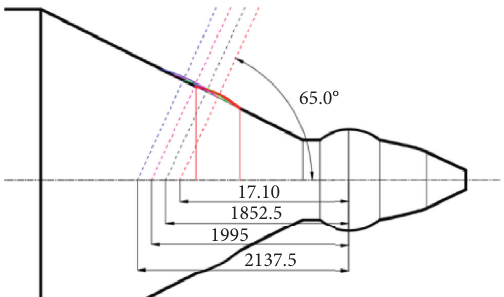
Figure 1: Schematic diagram of the distance between guide vane and blade.